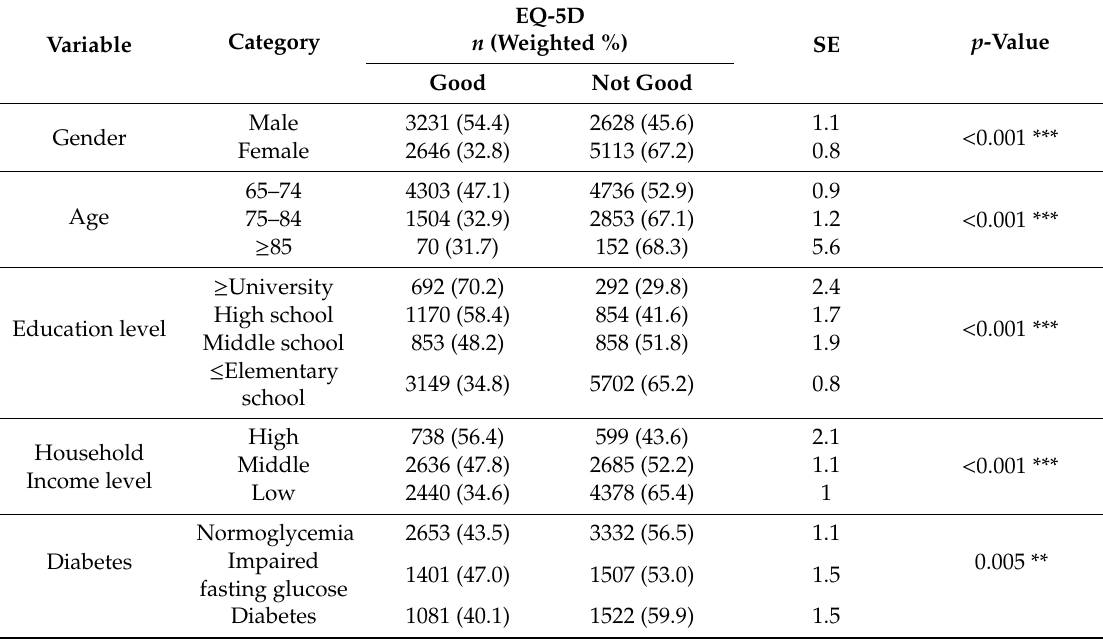
Table 1. Health-related quality of life (EQ-5D score) according to general characteristics and oral discomfort problems ( n =